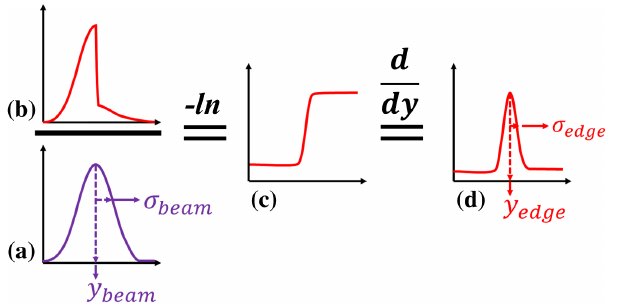
FIG. 2. Beam and edge analysis. (a) Beam profile along with Gaussian fit parameters. (b) Edge profile which is then normal- ized by (a). The negative logarithm of this normalized profile is shown in (c). The spatial derivative of the profile in (c) results in a peak shown in (d) along with its Gaussian fit